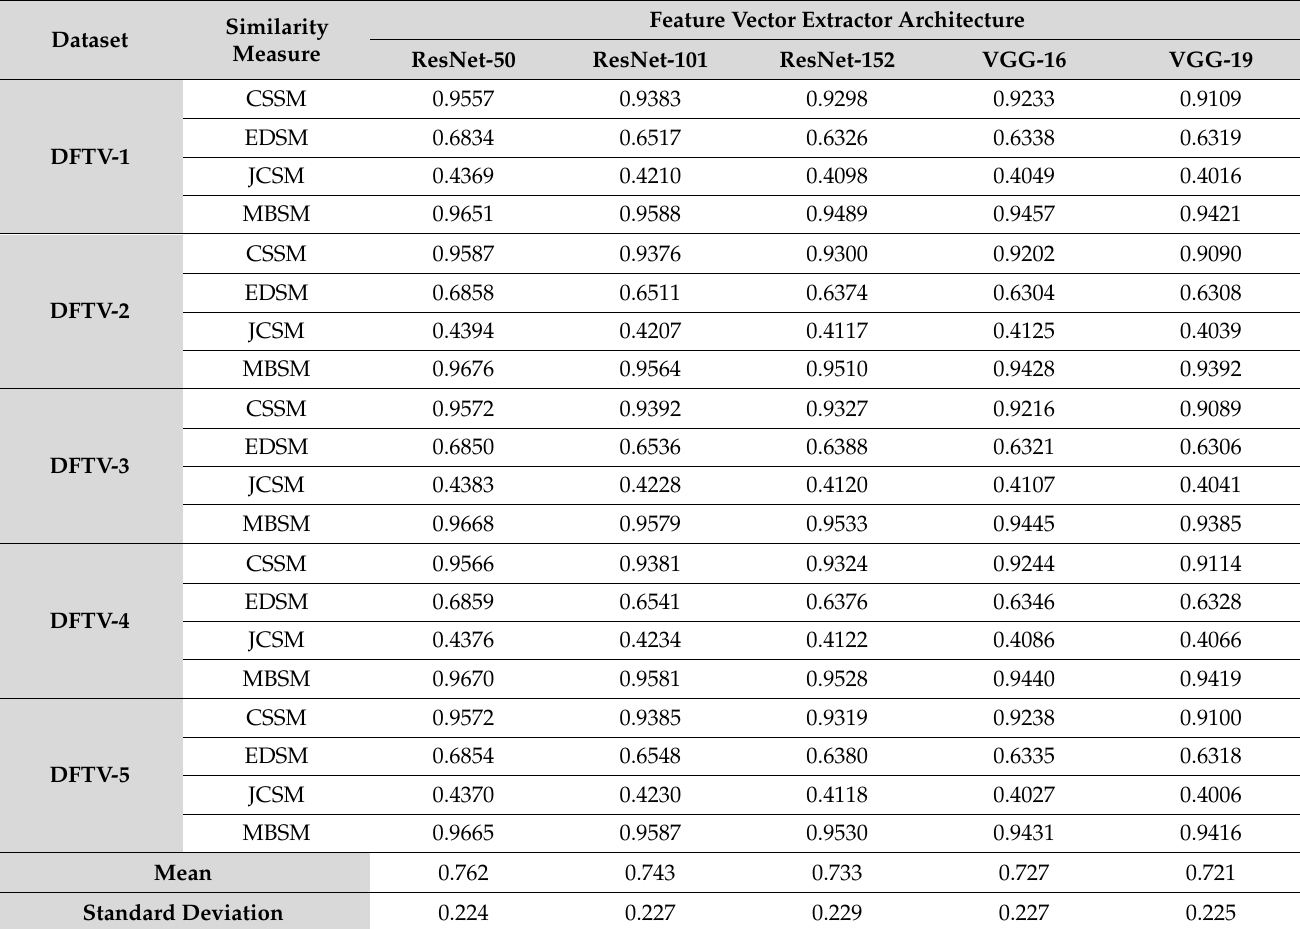
Table A1. Average highest cosine similarity (AHS) obtained for the CNN models with DFTV